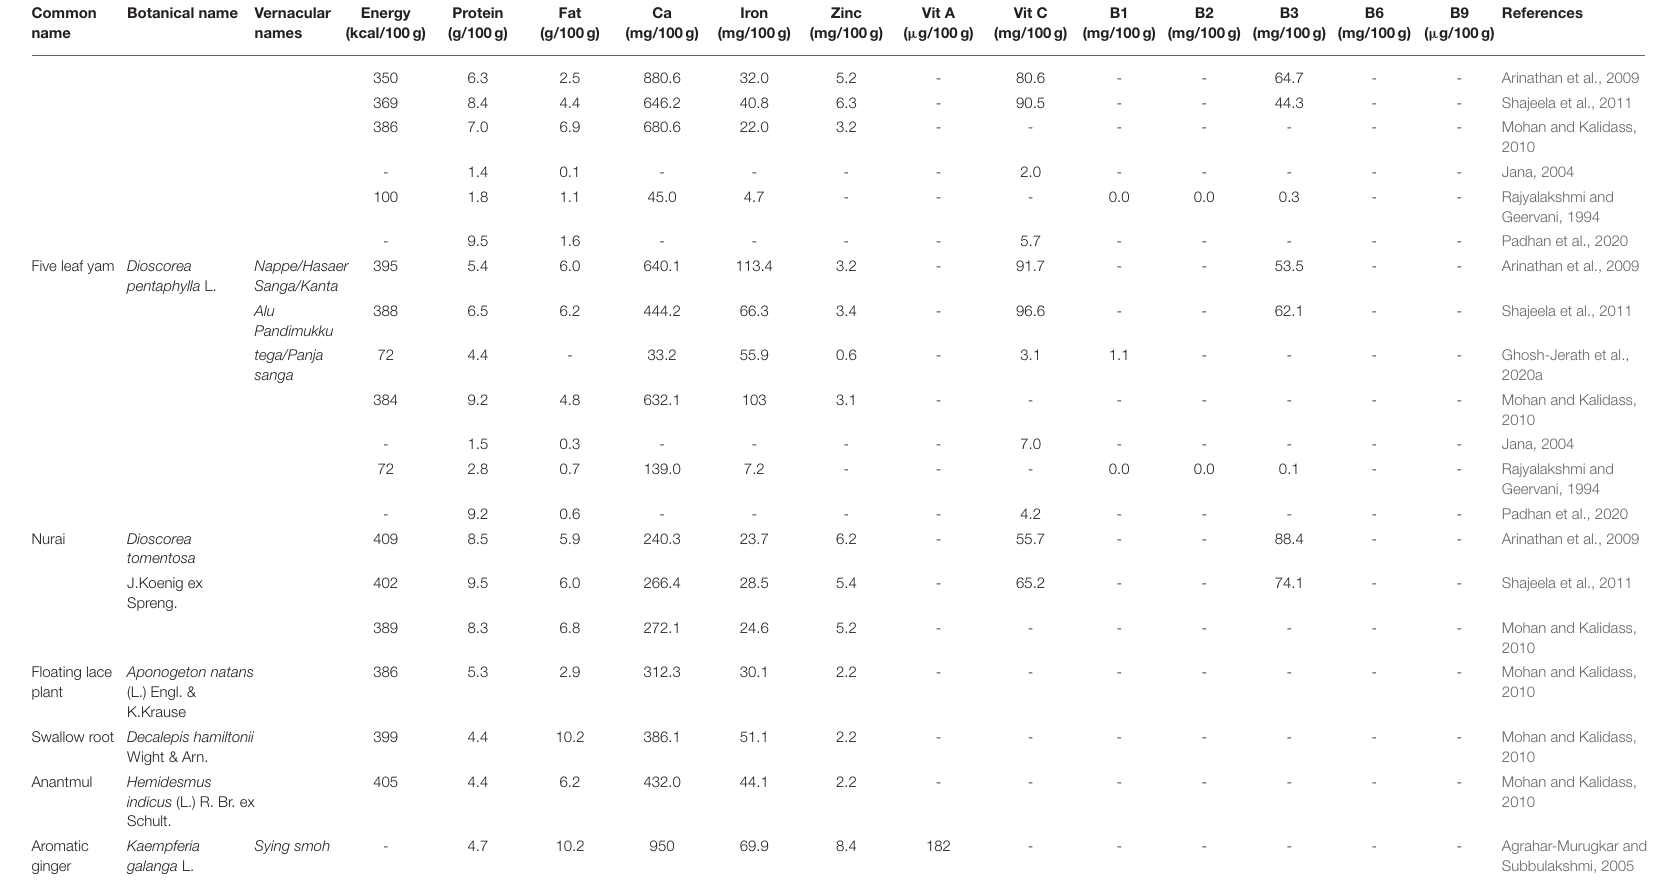
Aromatic ginger